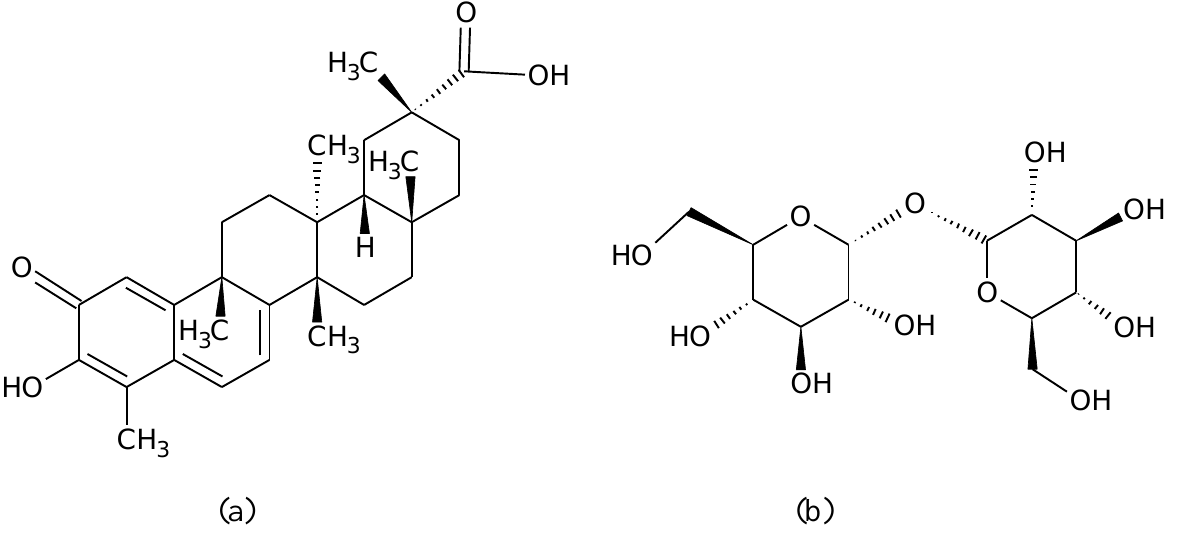
Figure 10. Chemical formula of ( a ) celastrol and ( b ) trehalose.